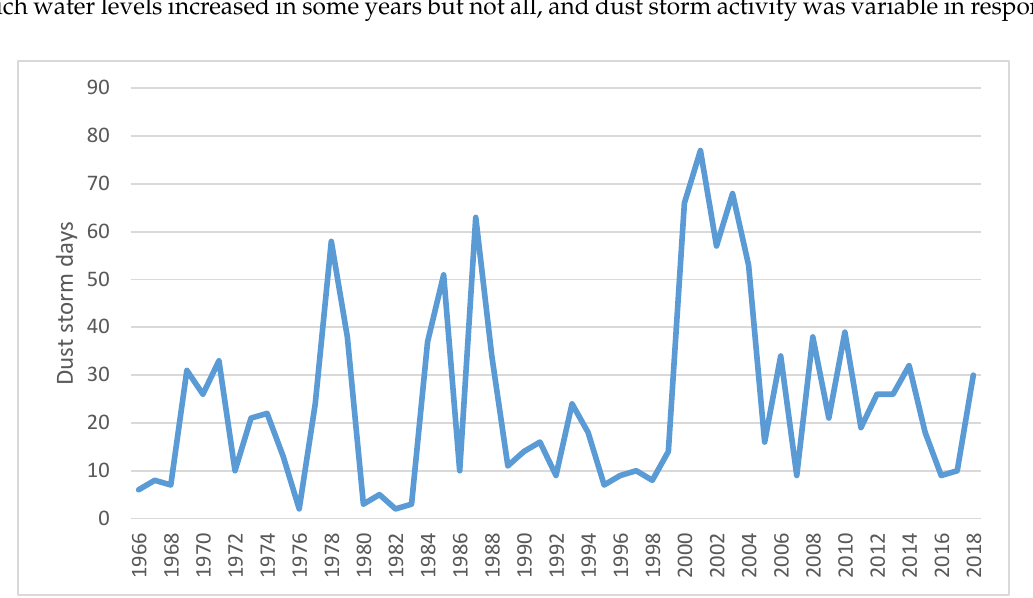
Figure 2. Annual frequency of dust storm days 1966 – 2018 at Zabol (31.09° N, 61.54° E). (Data source: Zabol meteorological station).